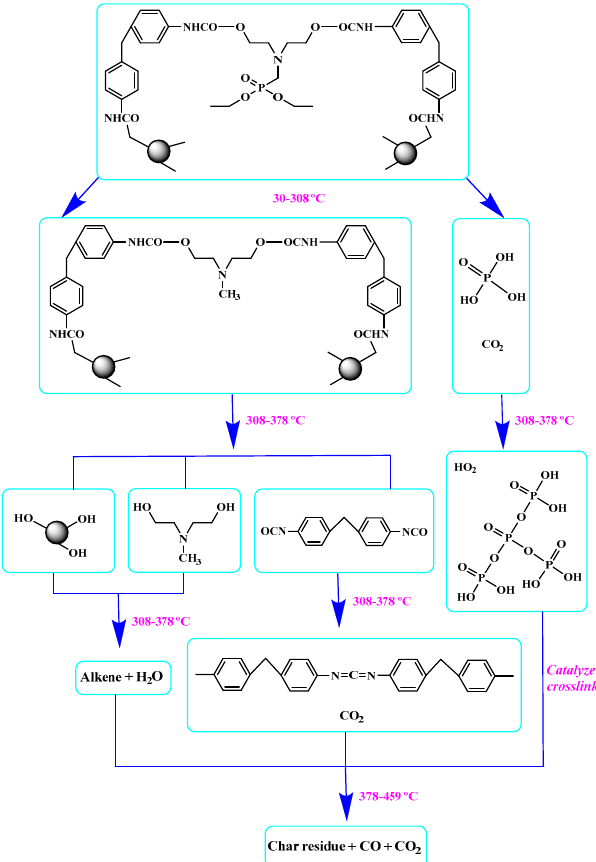
Figure 4. Mechanism of thermal degradation for flame retardant (FR bio-based PU proposed by Ding el al. [96].